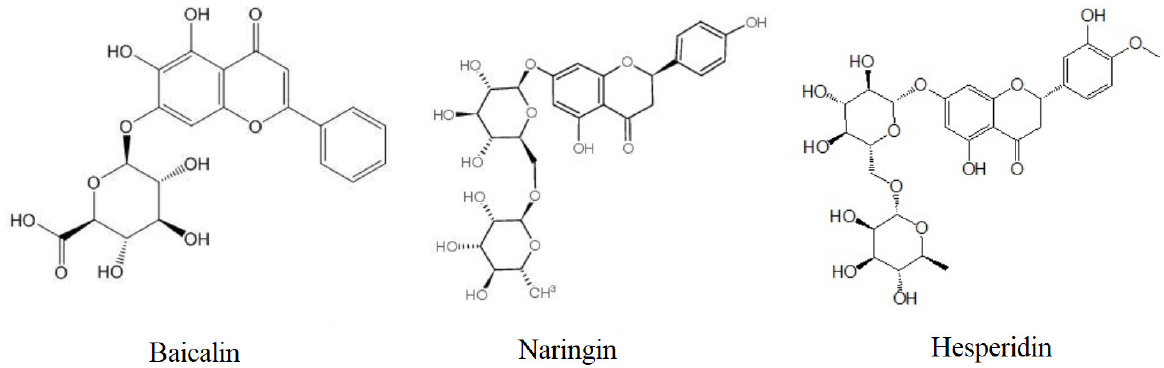
Figure 1. Chemical structures of flavonoids, baicalin, naringin, and hesperidin.